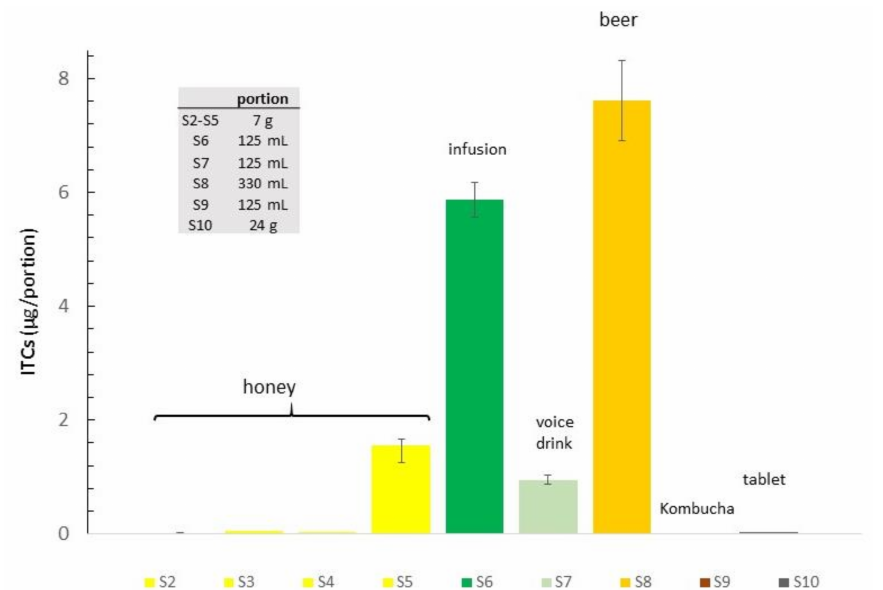
Figure 3. Comparison of released ITCs (isothiocyanates) content in single portions of food and drink preparations. Full description of samples S1–S10 is reported in Table